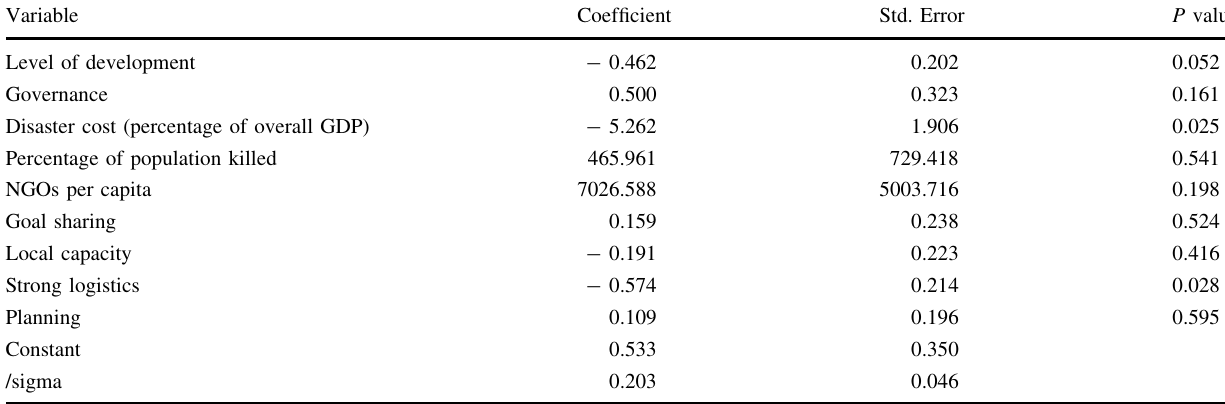
Table 2 Estimated Tobit regression coefficients for nine variables that explore the friction/coordination dichotomy in 17 disaster events